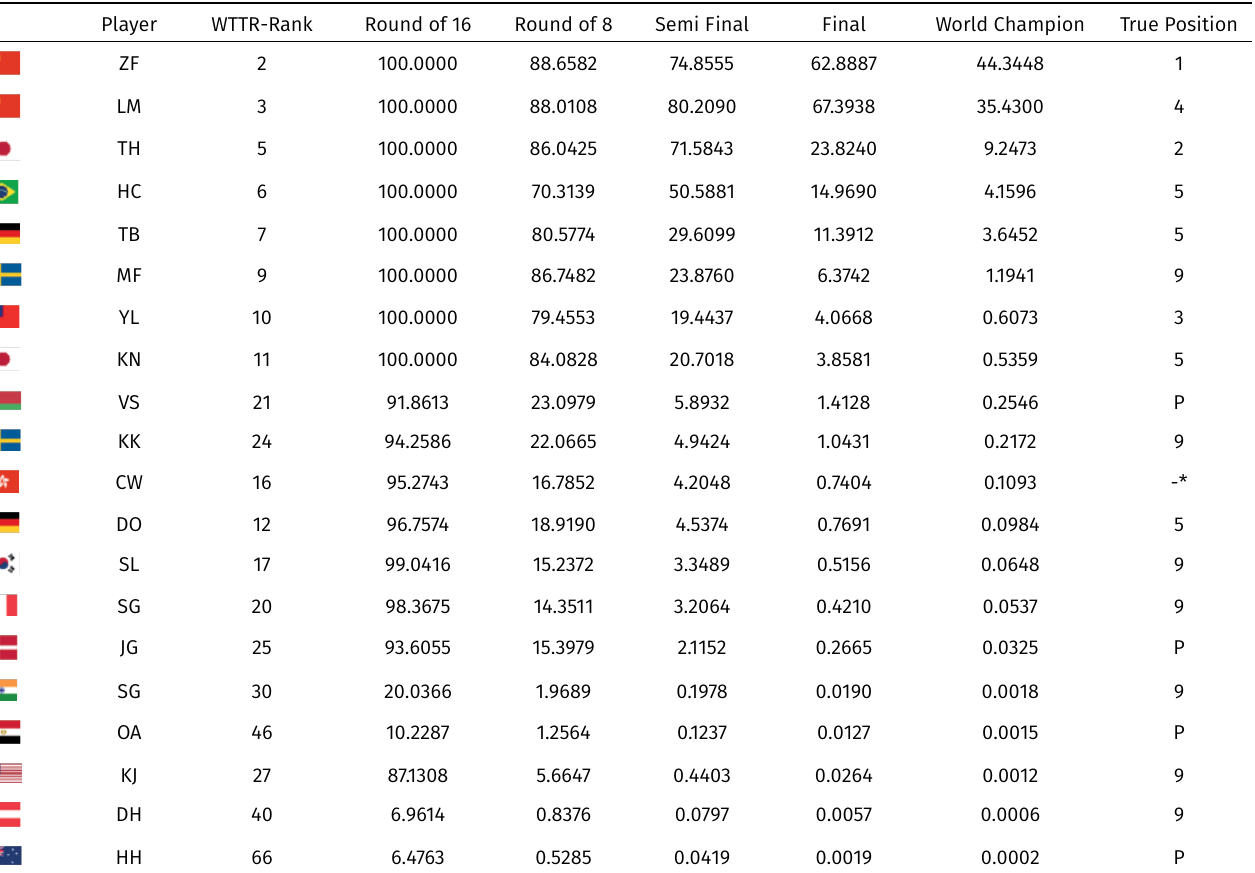
Table 6. Probabilities for reaching different stages at the 2019 ITTF Men’s World Cup for each participant based on the random forest model. Player WTTR-Rank Round of 16